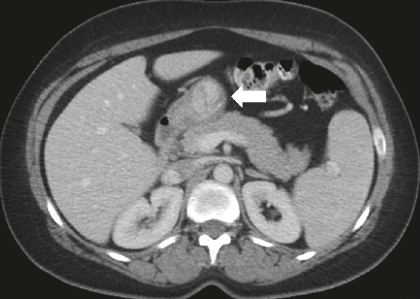
Figure 3: CT image of glomus tumor. The arrow is pointing to a hyperenhancing, prepyloric, submucosal mass.